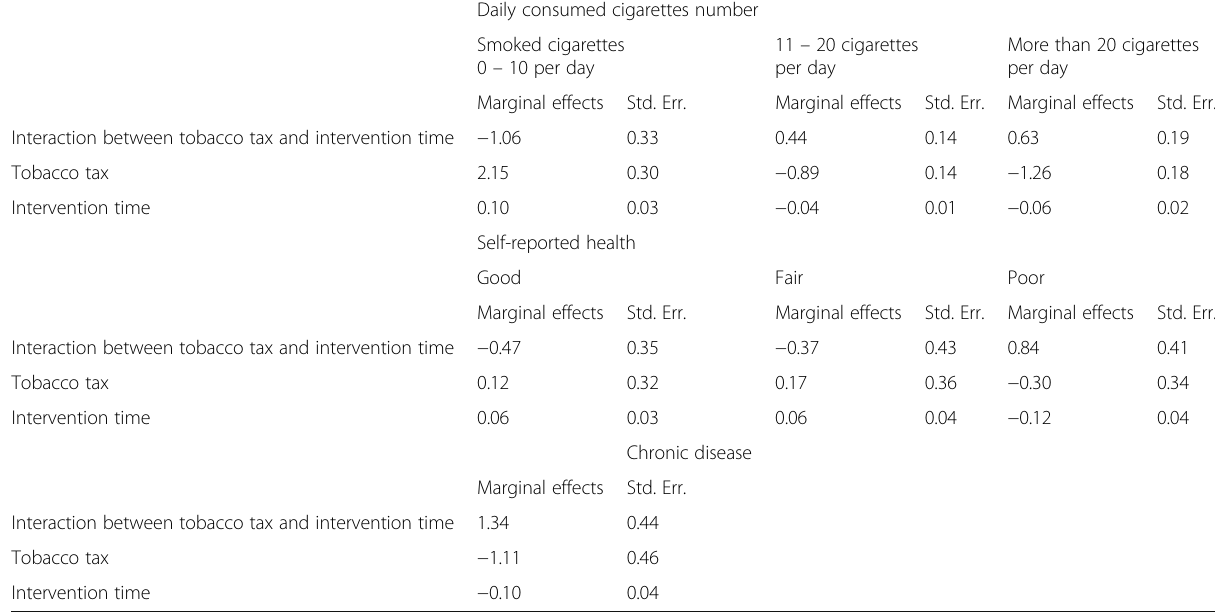
Table 4 Marginal Effects of the Excise Tax Rate at producer level in 2009 on smoking behaviors and health status